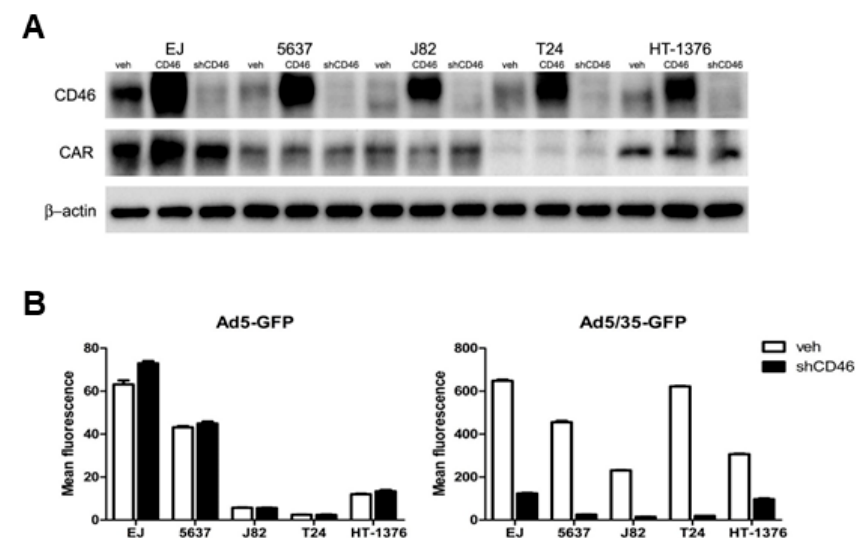
Figure 5. Gene transduction efficiency of Ad5 or Ad5/35 in CD46-altered bladder cancer cells. ( A ) Overexpression (CD46) and suppression (shCD46) of CD46 in bladder cancer cells relative to mock treated cells (veh) were confirmed by Western blot analysis. ( B ) Flow cytometry analysis of virus-mediated GFP transduction in CD46-suppressed and vehicle control cells was performed 24 h post infection. The error bars represent SEM. Statistics: B, p < 0.05 by two-way ANOVA.